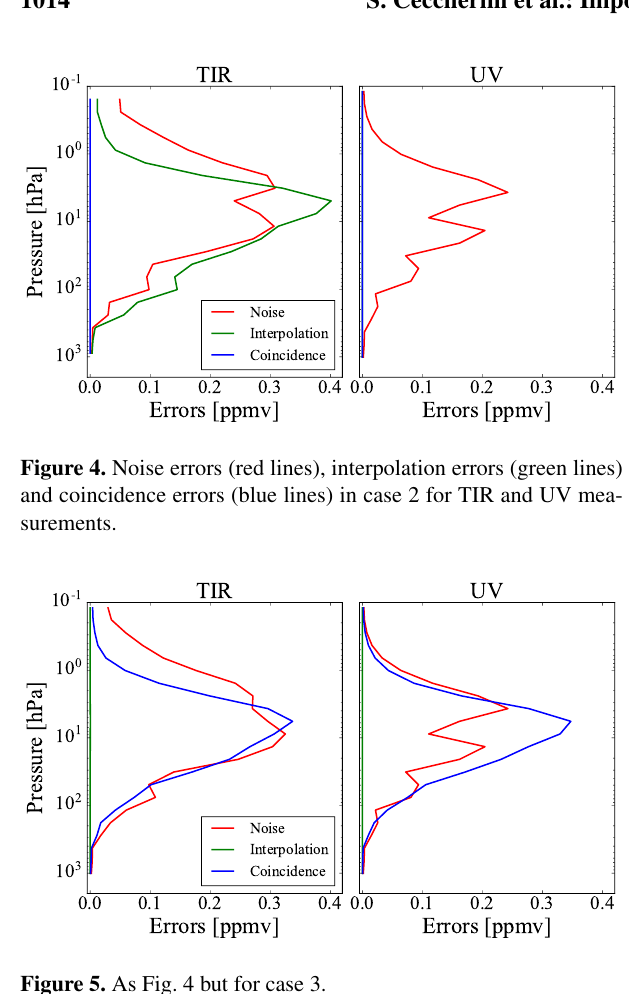
Figure 7. The fused profile and the residual error obtained with the modified algorithm (magenta lines) compared with the same quan- tities of Fig. 3b and